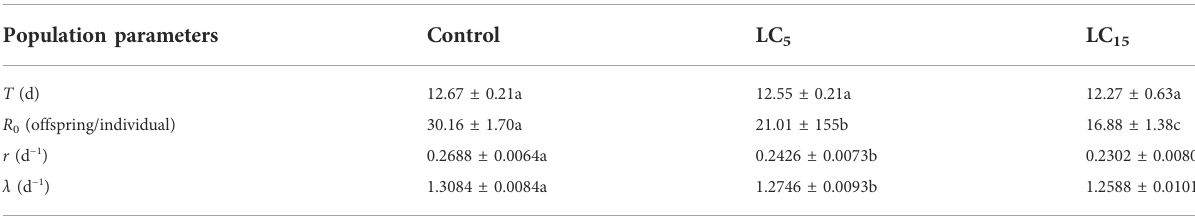
TABLE 4 Sublethal effects of Spirotetramat on population growth parameters (Mean ± SE) of F 1 generation of B. brassicae .